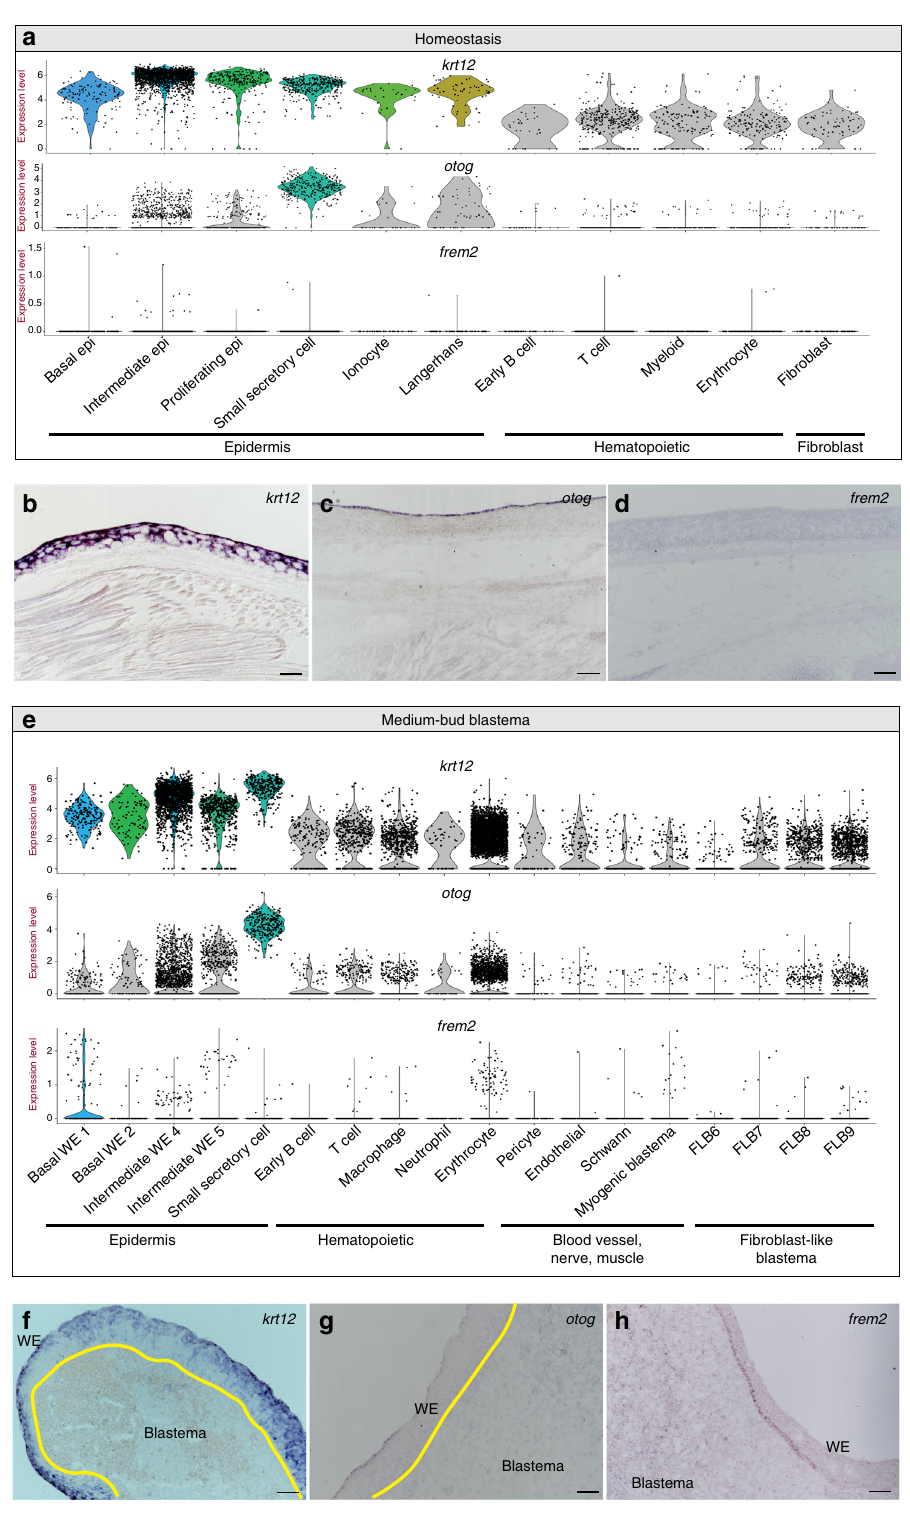
Fig. 2 Wound epidermis gene expression dynamics during regeneration. a Violin plots depicting log 2 values of normalized expression of krt12 , otog , and frem2 at homeostasis. b – d Representative RNA in situ hybridizations in limbs at homeostasis probing for krt12 ( b ) ( n = 5 animals), otog ( c ) ( n = 3 animals), and frem2 ( d ) ( n = 3 animals). e Violin plots depicting log 2 values of normalized expression of krt12 , otog , and frem2 in the medium-bud blastema. f – h Representative RNA in situ hybridizations in medium-bud blastemas probing for krt12 ( f ) ( n = 5 animals), otog ( g ) ( n = 3 animals), and frem2 ( h ) ( n = 5 animals). In violin plots ( a , e ), each dot represents an individual cell; epidermal populations of interest are depicted in color, all others are in gray. Yellow line in f , g denotes boundary between the wound epidermis and blastema. Epi epidermis, WE wound epidermis, FLB fi broblast-like blastema cell. Magni fi cation, ×10, scale bars are 100 μ